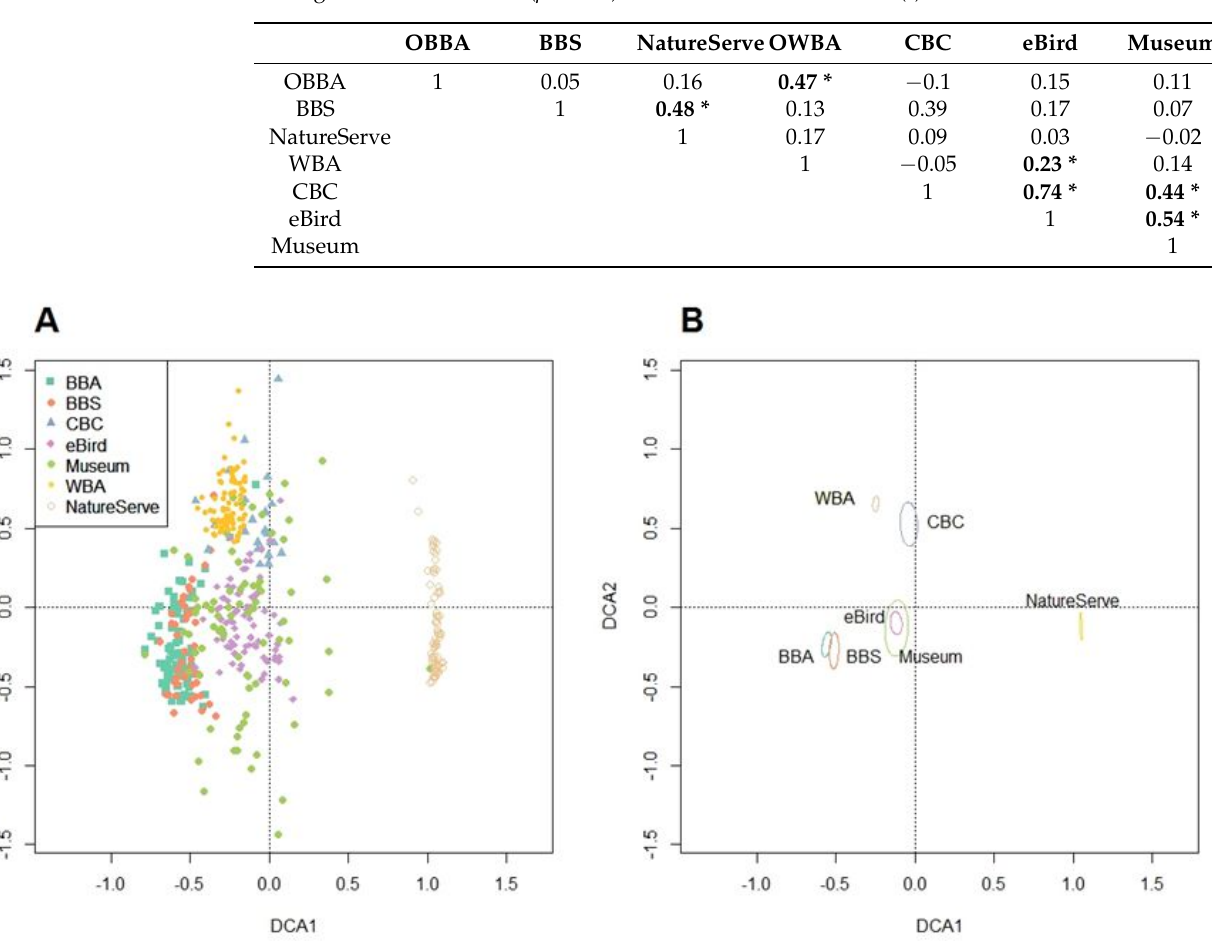
Figure 4. The results of the Detrended Correspondence Analysis (DCA). The raw DCA scores for each method are shown in ( A ), while ellipses showing 95% confidence intervals for the DCA scores are shown in ( B ). Avian communities represented in museum and eBird databases overlap completely, showing that both approaches sample similar communities. In contrast WBA and CBC sample significantly different communities. Joint range maps created by BirdLife International and NatureServe sample significantly different communities from all other approaches.